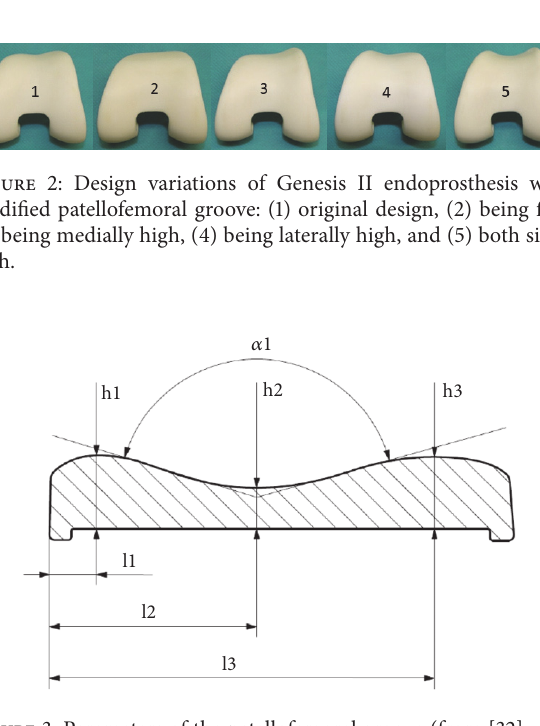
Figure 3: Parameters of the patellofemoral groove (from [32] with permission of the